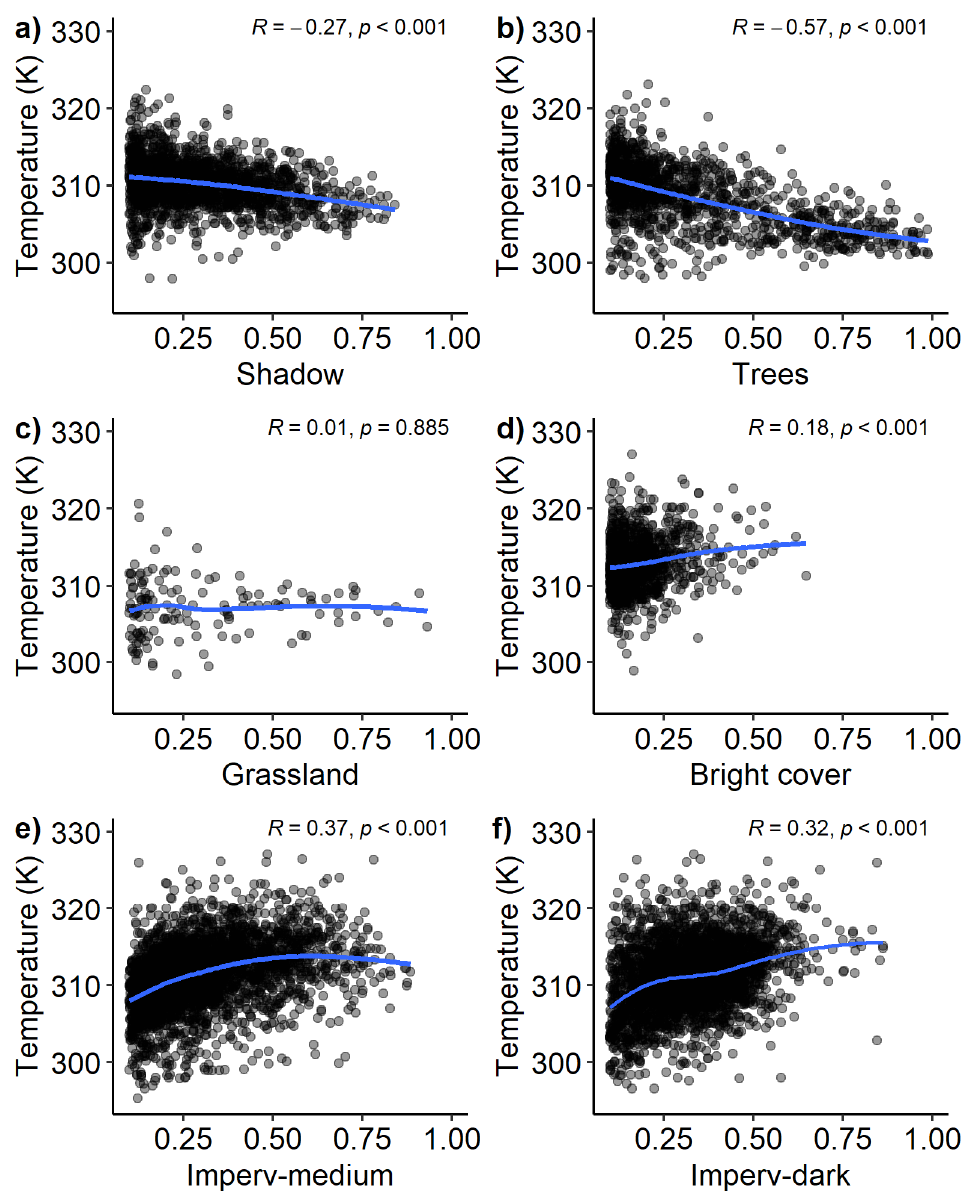
Figure 4. Relationship between ASTER surface temperature (K) and the fraction of different urban components >10%. Pearson correlation coefficient (R) and level of statistical significance ( p values) is shown. Solid lines indicate a locally weighted scatterplot smoothing (LOWESS) function. Sub-plot ( a – f ) shows individual relationships of urban components with surface temperature.